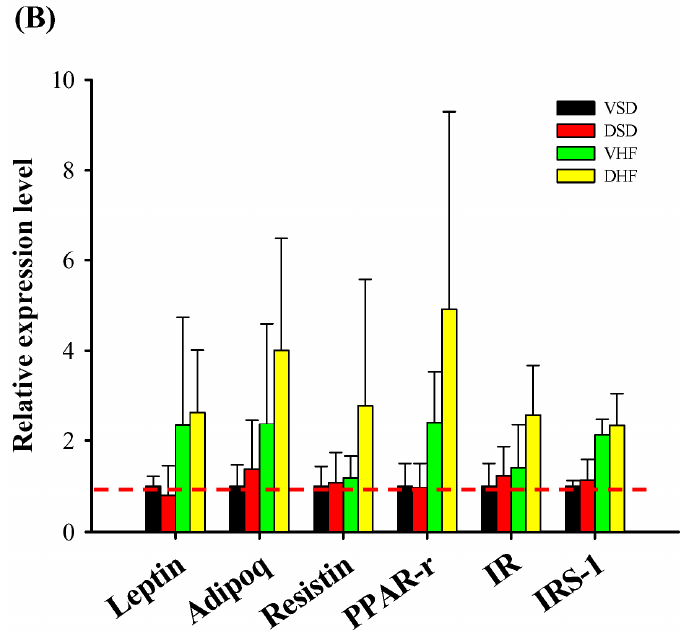
Figure 6. Adipose mRNA transcript levels: ( A ) epididymal fat; and ( B ) omentum fat. The red dotted line represented that the relative gene expression was 1 when compared to VSD group. PPAR-r, Peroxisome proliferator-activated receptor gamma. Data were compared by two-way ANOVA with post hoc least significant difference followed by LSD tests. * vs. VSD, p < 0.05; $, DSD vs. DHF , p < 0.05.